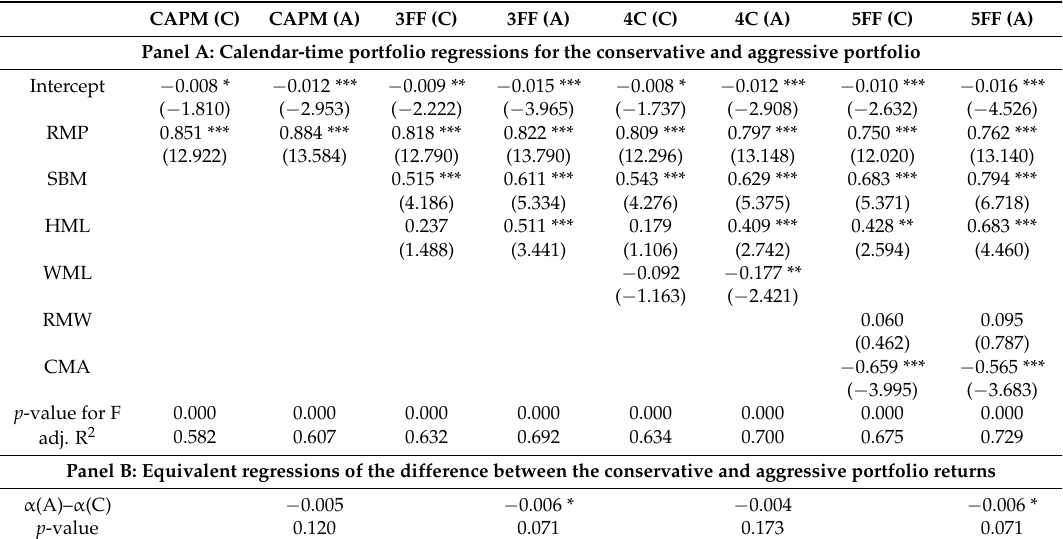
Table 5. Calendar-time portfolio regressions for year in quantiles according to the Ball–Shivakumar model.